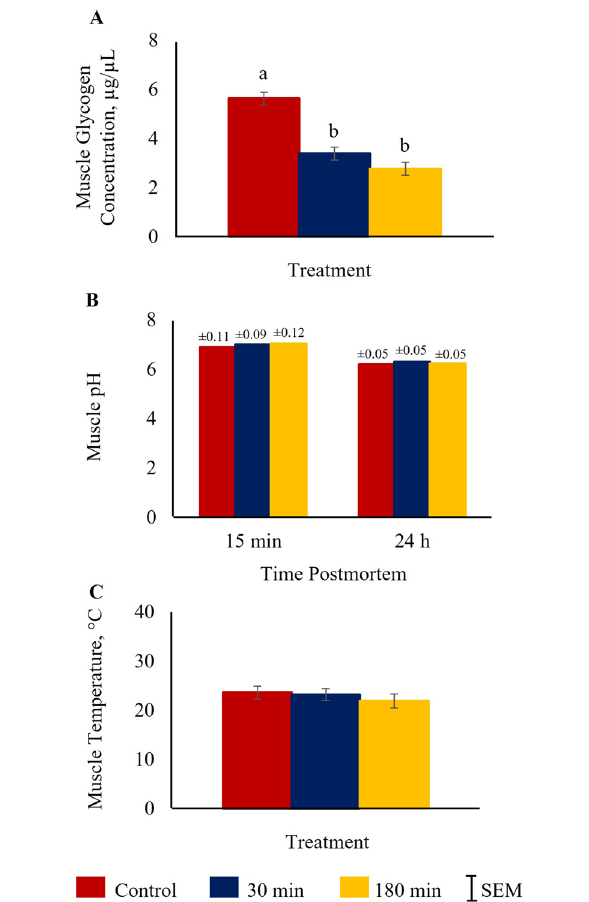
Figure 2. Effects of stress treatment (Control = not transported but held in pens; 30 min = transported for 30 min; 180 min = transported for 180 min) on mean ± SEM Longissimus dorsi muscle ( A ) glycogen concentration and ( B ) initial (15 min postmortem) and final (24 h postmortem) pH and ( C ) temperature (15 min postmortem) values in